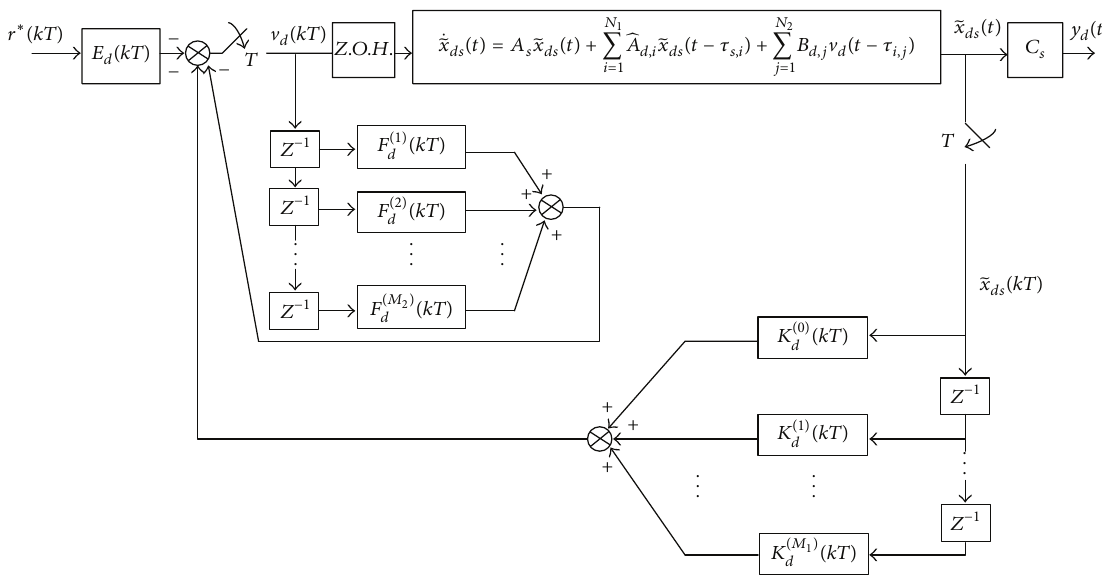
Figure 1: Digital redesign for time-delay singular